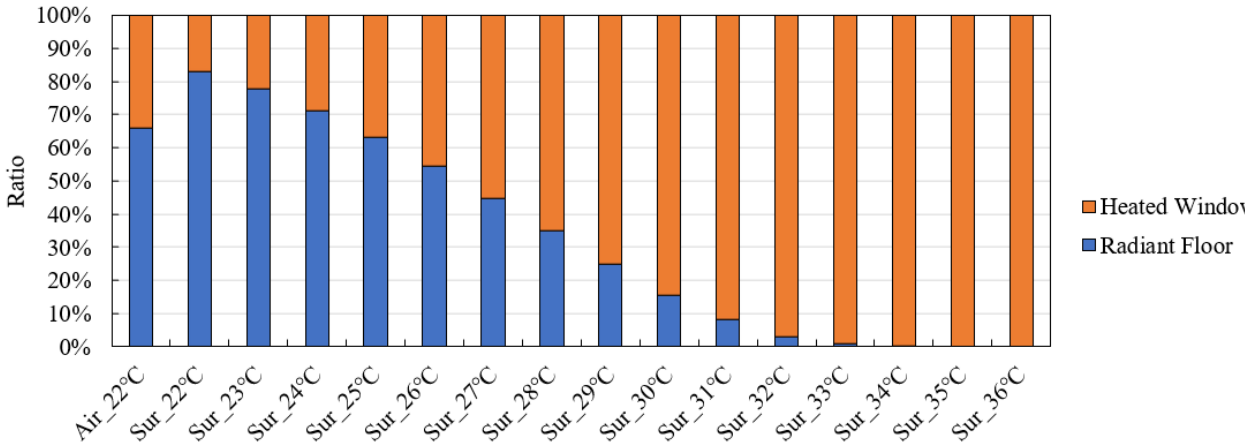
Figure 14. Ratio of monthly heating load to annual heating load.